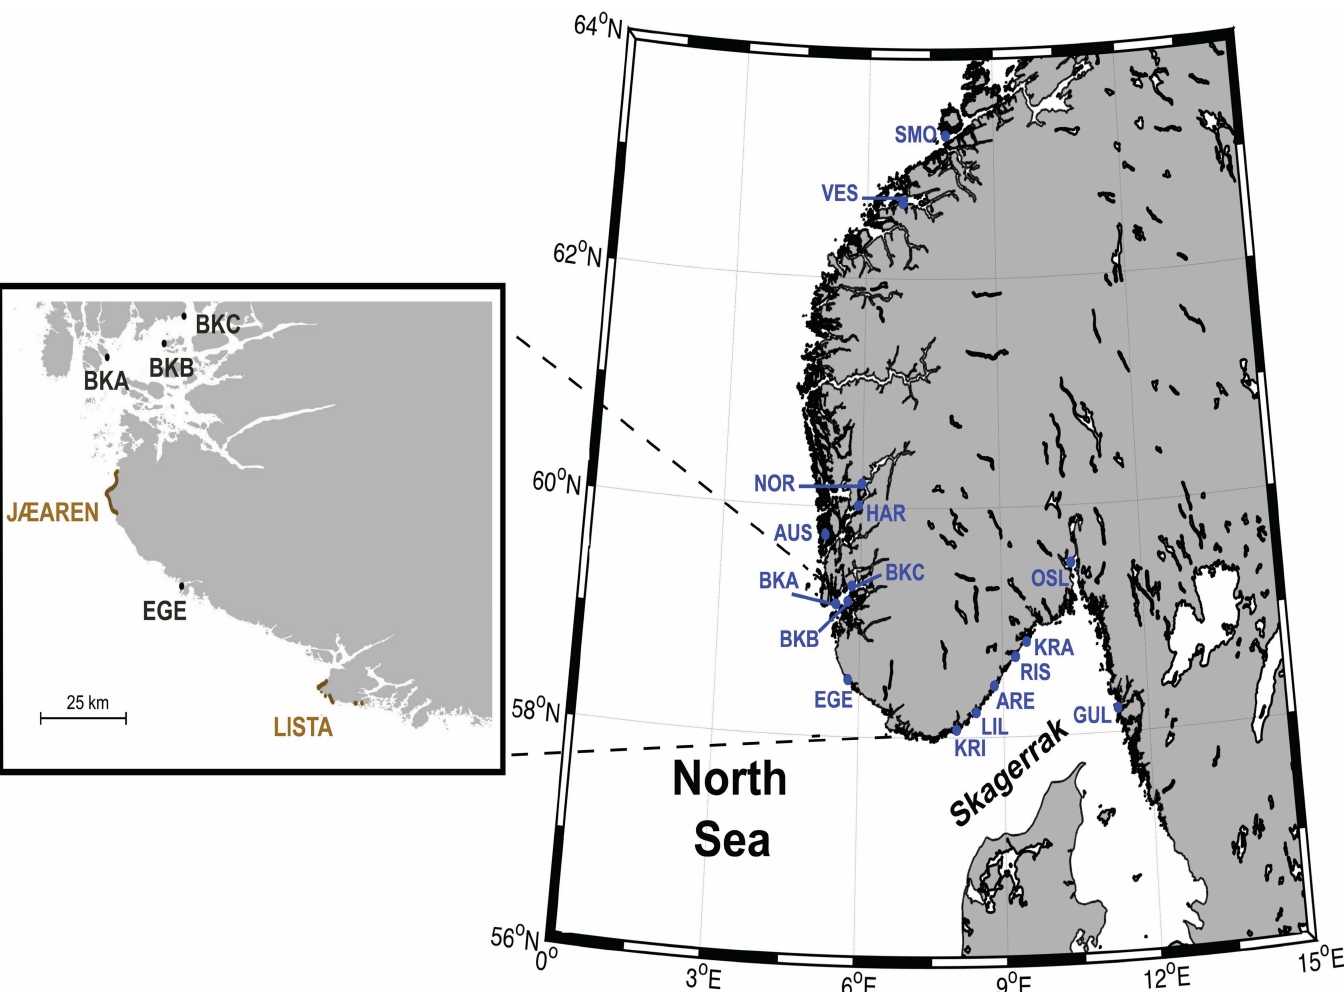
Fig 1. Samplinglocationsof corkwingwrasseanalysedin thisstudy (for detailsof sampleabbreviations see Table 1). The locationand geographical extension of the two majorsandy areas in Norway, Jærenand Lista, are indicatedin the inset.